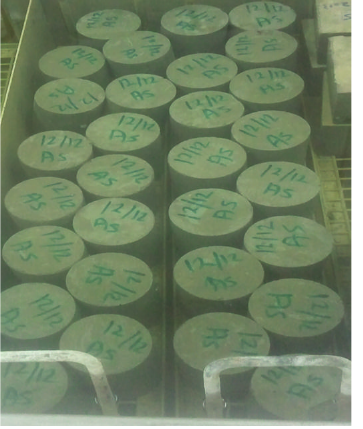
Figure 4: Curing of concrete cylinders.